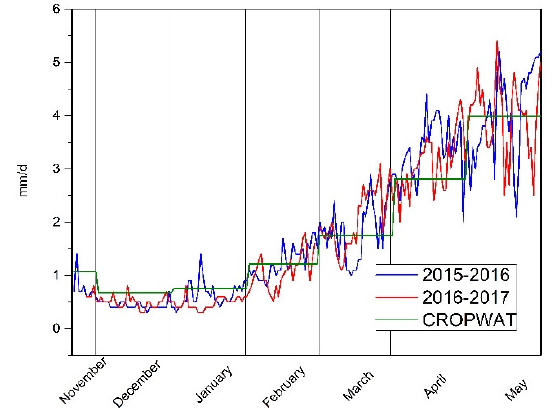
Figure 5. The reference evapotranspiration for 2015–2016 and 2016–2017 cultivation periods compared to the 30 year average ETo according to FAO database/CLIMWAT, Larissa region. Table 3. Soil texture analysis of the experimental plots (0–20 cm and 20–40 cm) (*).